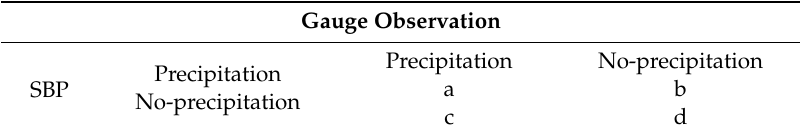
Table 2. Contingency table to define daily precipitation based categorical scores for the evaluation of SBP with gauge